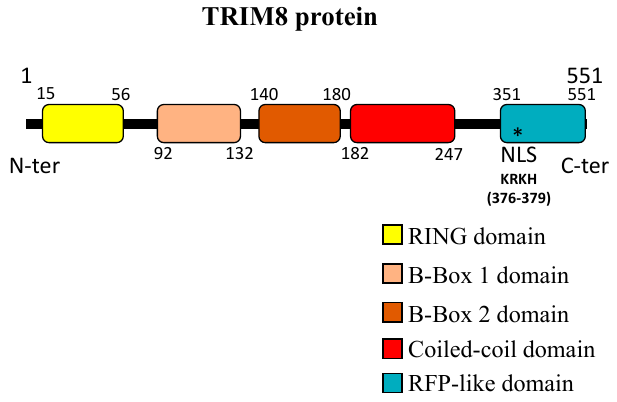
Figure 2. TRIM8 protein structure. The different TRIM8 domains are reported with the numbers indicating the first and the last aminoacid for each one.